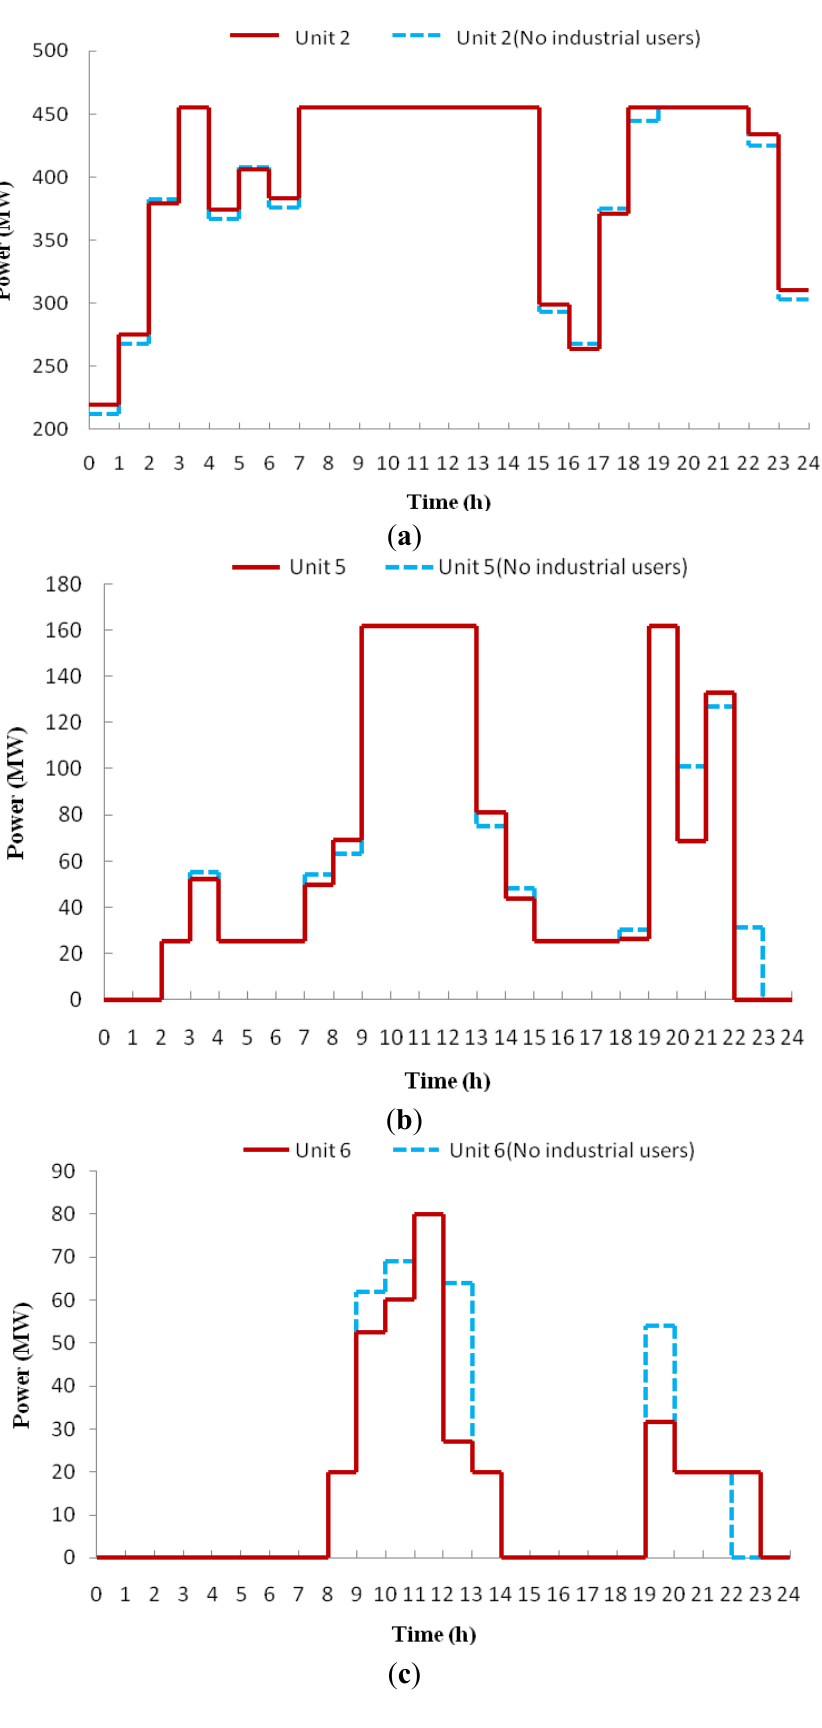
Figure 10. ( a ) Output of unit 2 in real-time scheduling; ( b ) Output of unit 5 in real-time scheduling; ( c ) Output of unit 6 in real-time